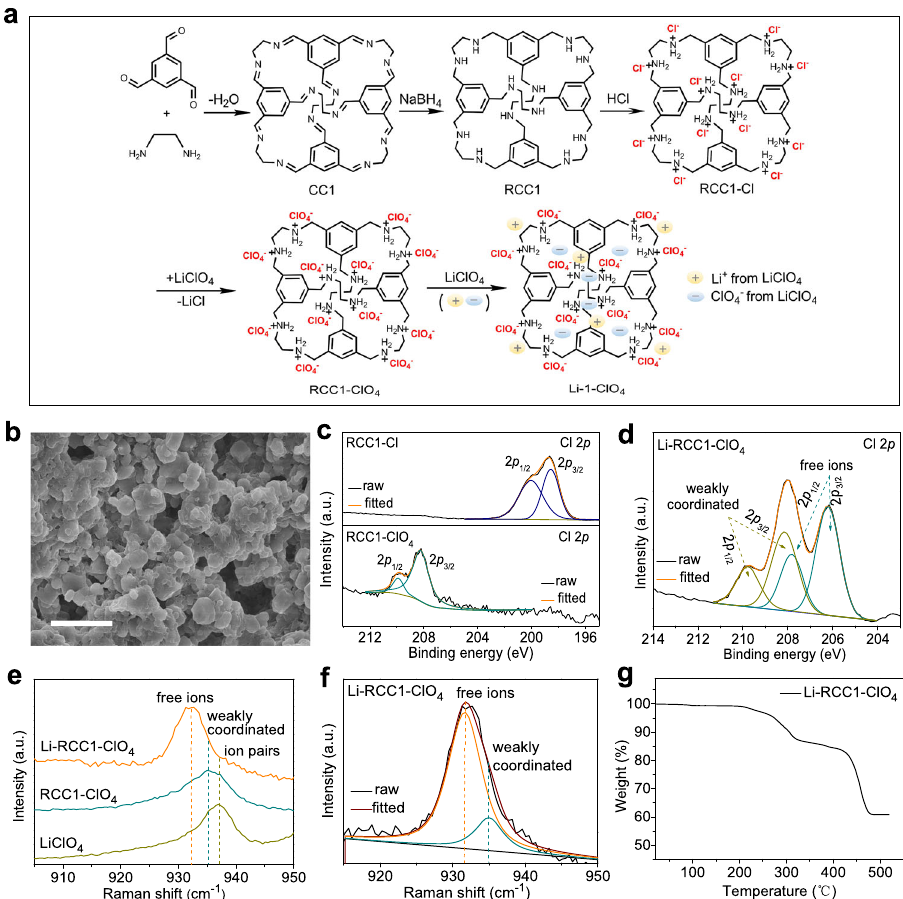
Fig. 1 Synthesis and characterization of the cage-based SSE, Li-RCC1-ClO 4 . a Synthetic procedure for the porous cage electrolyte Li-RCC1-ClO 4 . Note: the light yellow and blue symbol represent Li ion and ClO 4 ion from LiClO 4 , respectively. b SEM micrograph of Li-RCC1-ClO 4 powder. c , d XPS Cl 2 p spectra of RCC1-Cl, RCC1-ClO 4 , and Li-RCC1-ClO 4. e Raman spectra of LiClO 4 , RCC1-ClO 4 and Li-RCC1-ClO 4 . f Fitting of the Li-RCC1-ClO 4 Raman spectrum in the range of 915~950 cm − 1 . g Thermogravimetric analysis for Li-RCC1-ClO 4 under N 2 atmosphere (heating rate: 10 °C/min) . Scale bar for b is 5 μ